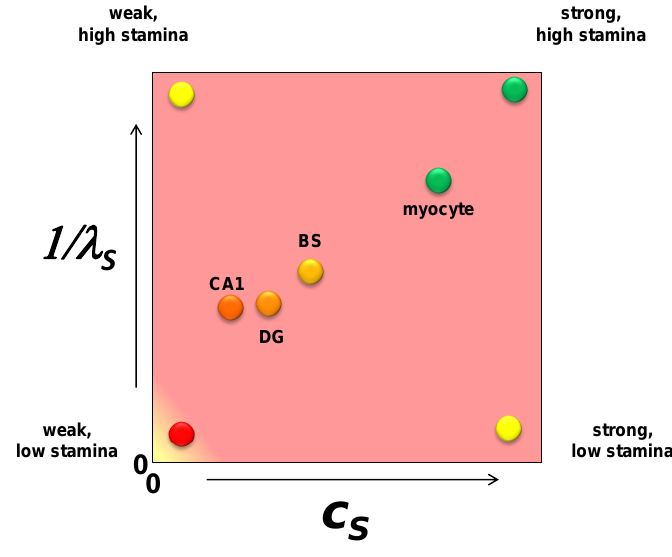
Figure 4. A plot of c vs. 1/ λ with hypothetical values for a CA1 pyramidal neuron (CA1), S S a dentate gyrus granule neuron (DG), a brainstem motorneuron (BS) and a skeletal muscle myocyte. The labels at each vertex indicate the qualitative interpretation of the